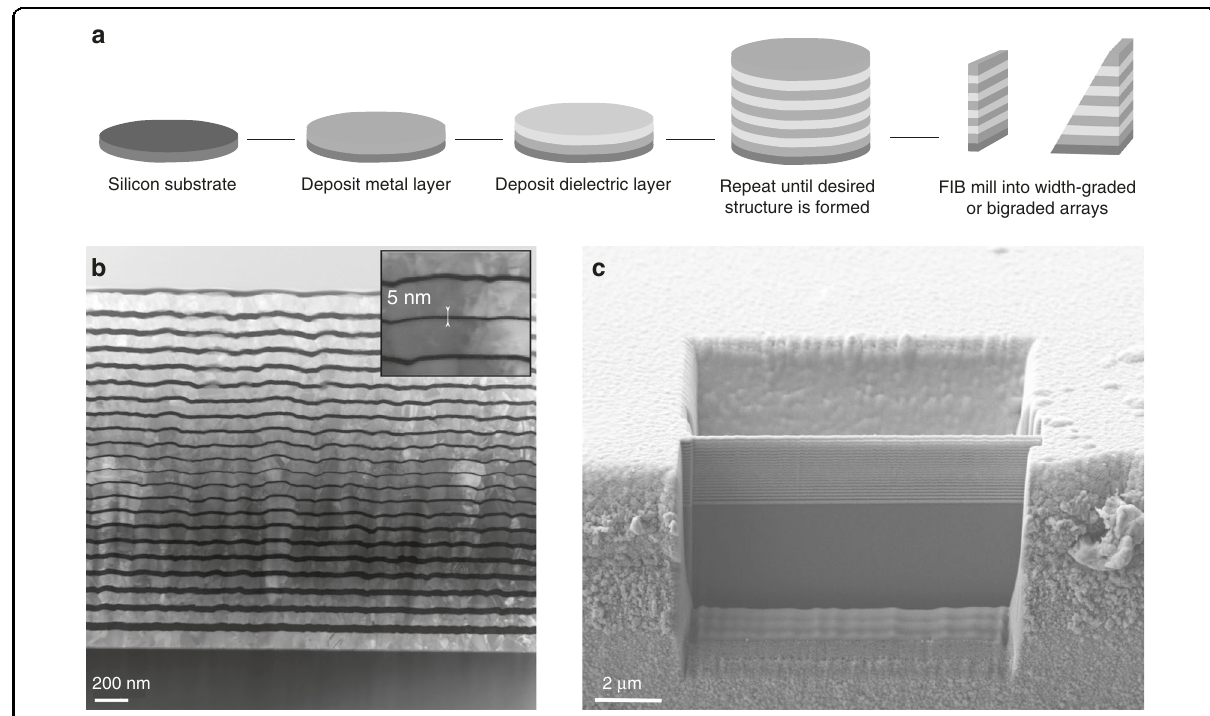
Fig. 4 Fabrication of MIM multilayer arrays. a Schematic illustration of the fabrication process. b TEM image of a symmetric sputter deposited alternating-layer array structure with central groove width of 5nm shown in the inset. The silver and magnesium fl uoride layers are light grey and black, respectively. c SEM image of a cross sectional slice of the same layered structure milled using FIB. The excavated regions on both sides of the device provide free space boundaries at both ends of the